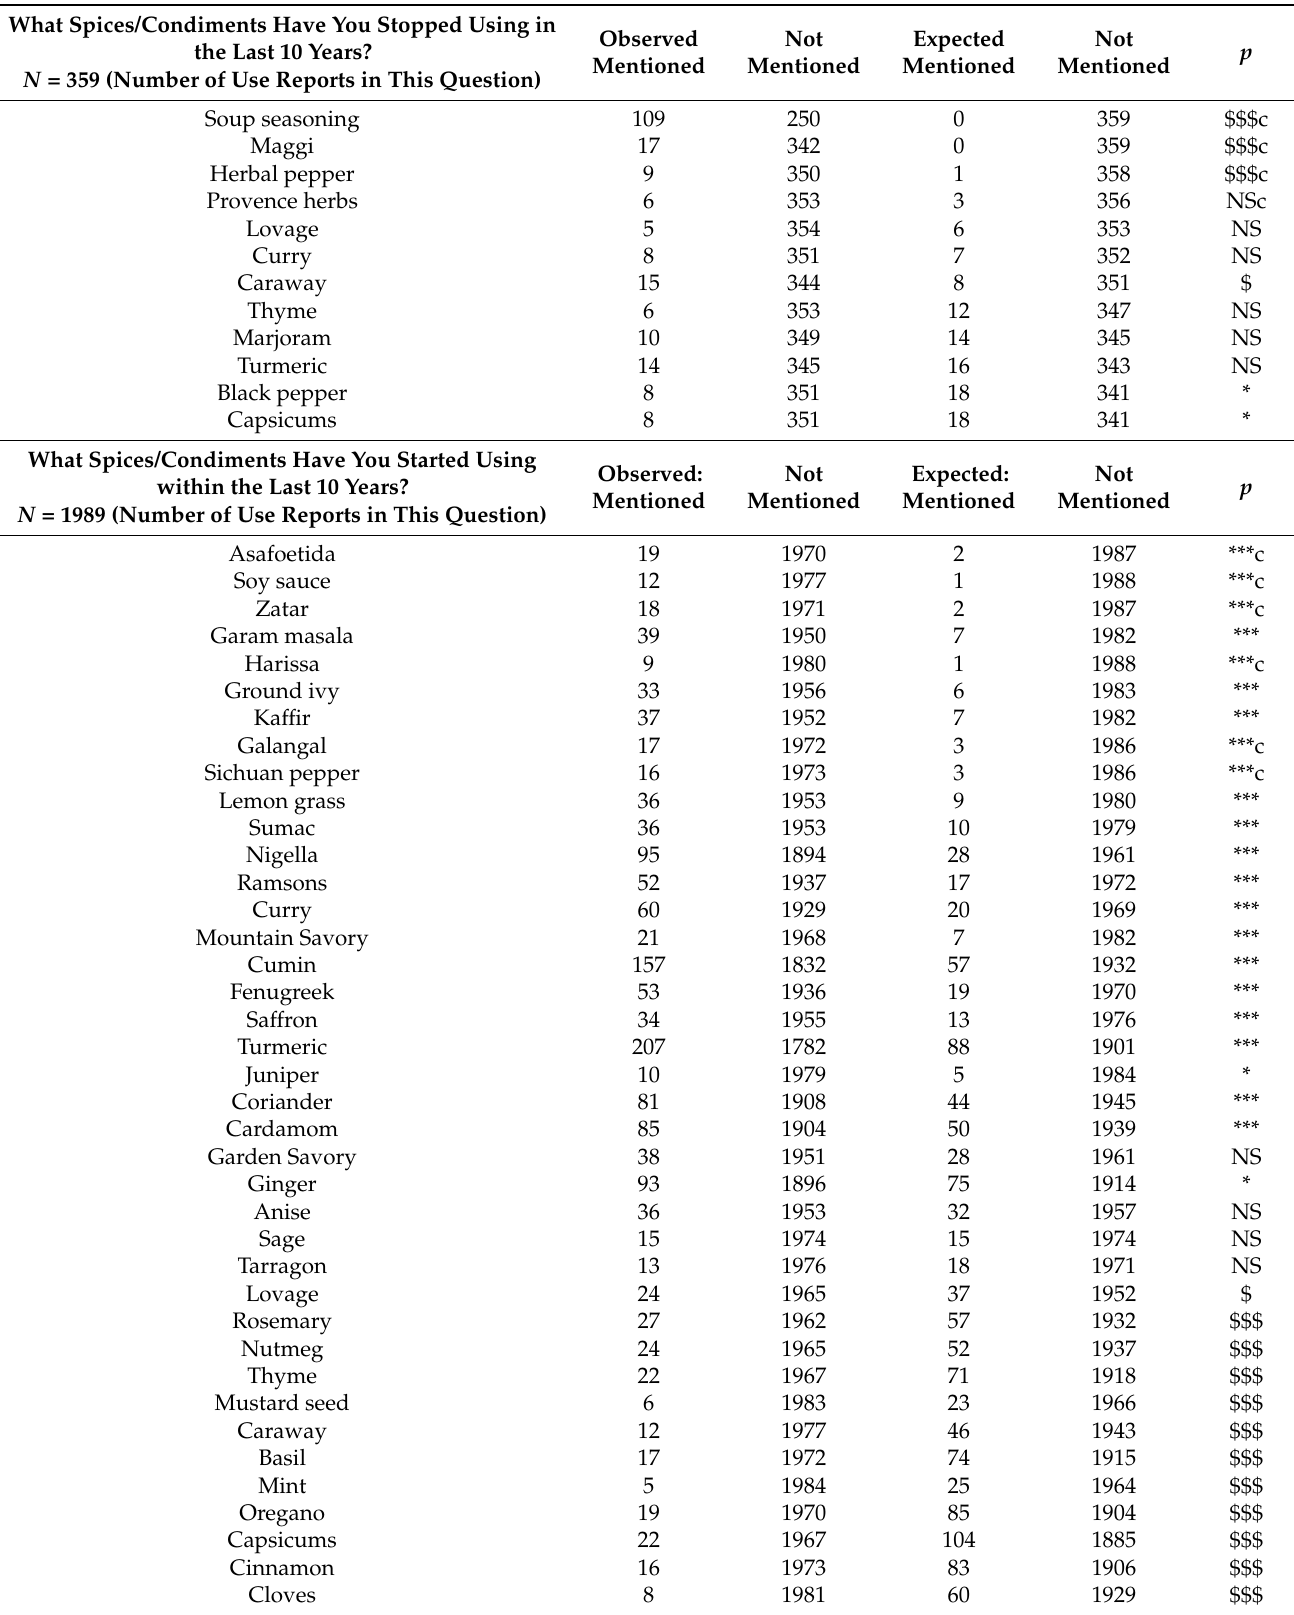
Table 5. Chi-Squared (X 2 ) table comparing the frequency of mention of spices in the questions about the use of spices. The expected frequency is based on the frequency of spices used at least once a